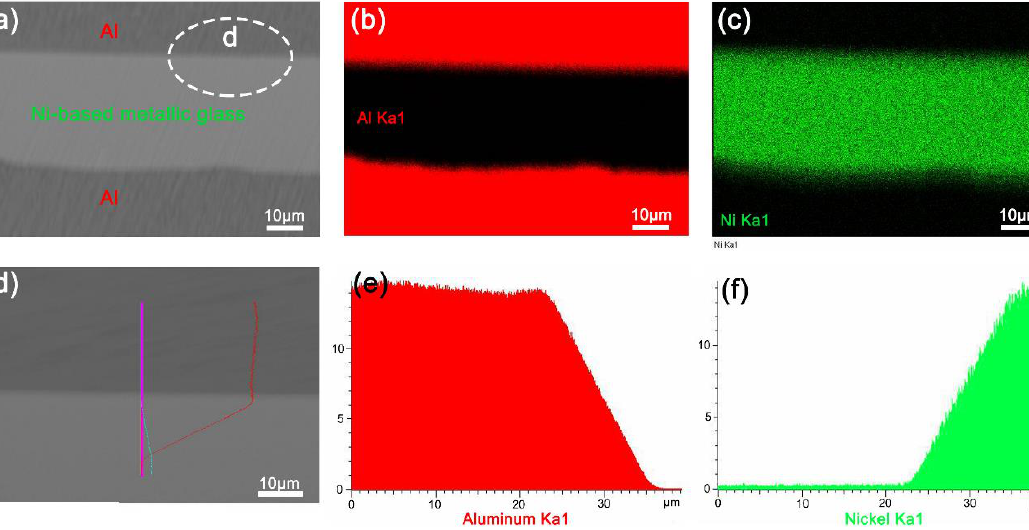
Table 1. Ultrasonic bonding experiment parameters.